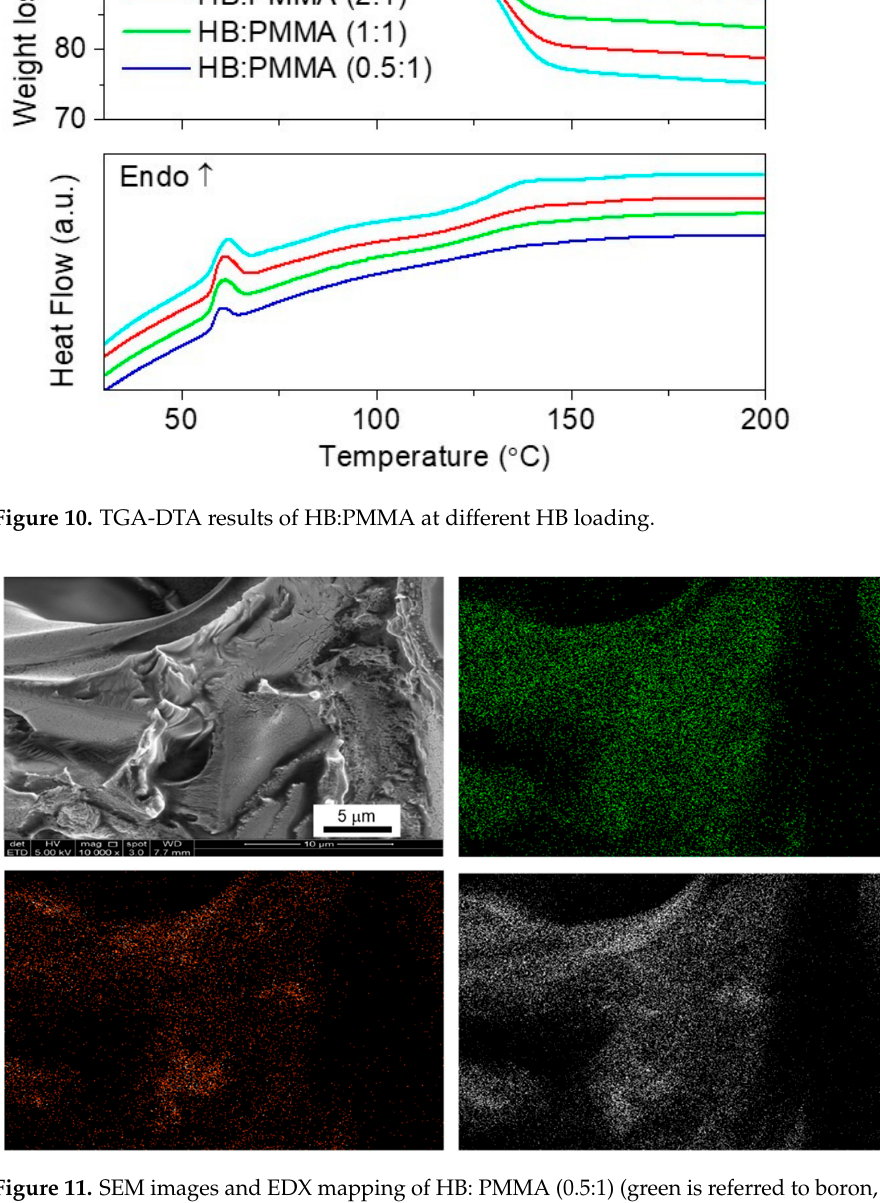
Figure 11. SEM images and EDX mapping of HB: PMMA (0.5:1) (green is referred to boron, orange to nitrogen and white to oxygen).